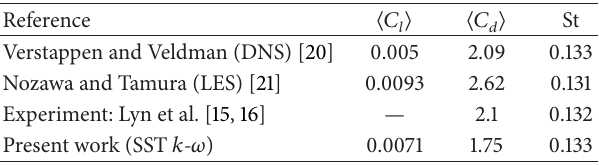
Table 1: Comparisons of average 𝐶 𝑙 , 𝐶 𝑑 and